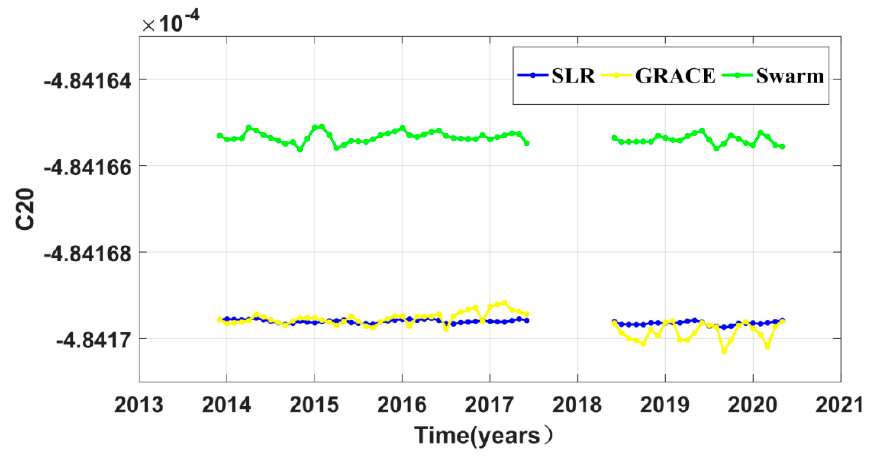
Figure 6. C 20 time series.